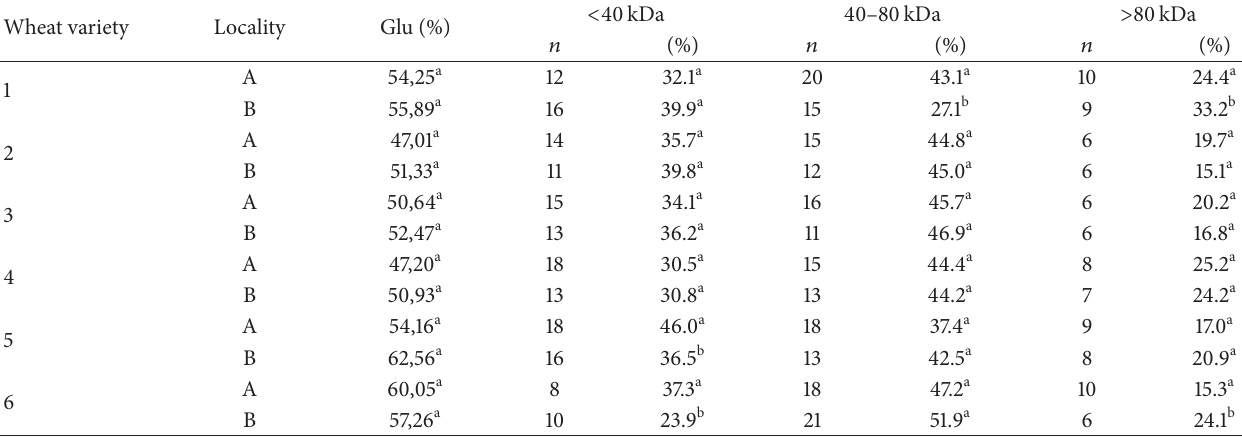
Table 2: The number of bands and relative amount of glutenin subunits within the selected molecular weight ranges for wheat varieties from observed localities. Wheat